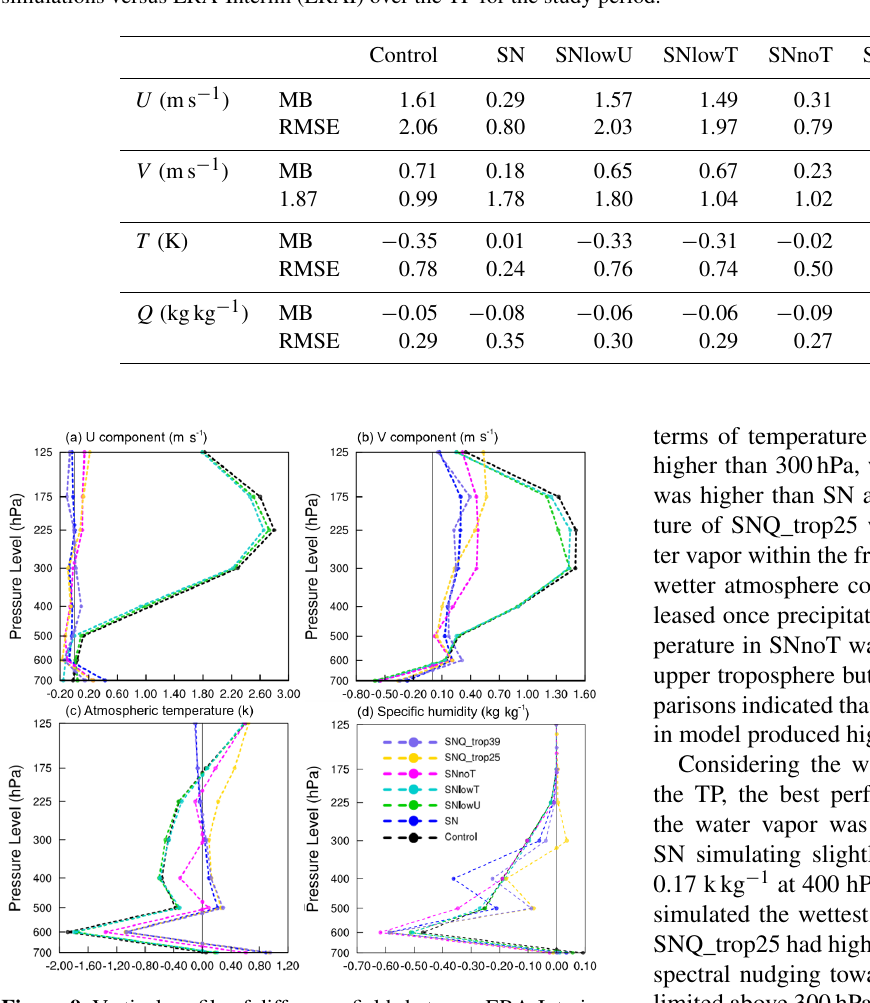
Figure 9. Vertical profile of difference fields between ERA-Interim and seven WRF simulations averaged over the study period for the (a) zonal wind component ( U ; ms − 1 ), (b) meridional wind compo- nent ( V ; ms − 1 ), (c) atmospheric temperature (K), and (d) specific humidity (kgkg − 1 ) over the TP. The vertical solid gray line repre- sents the value of 0.0 at each pressure